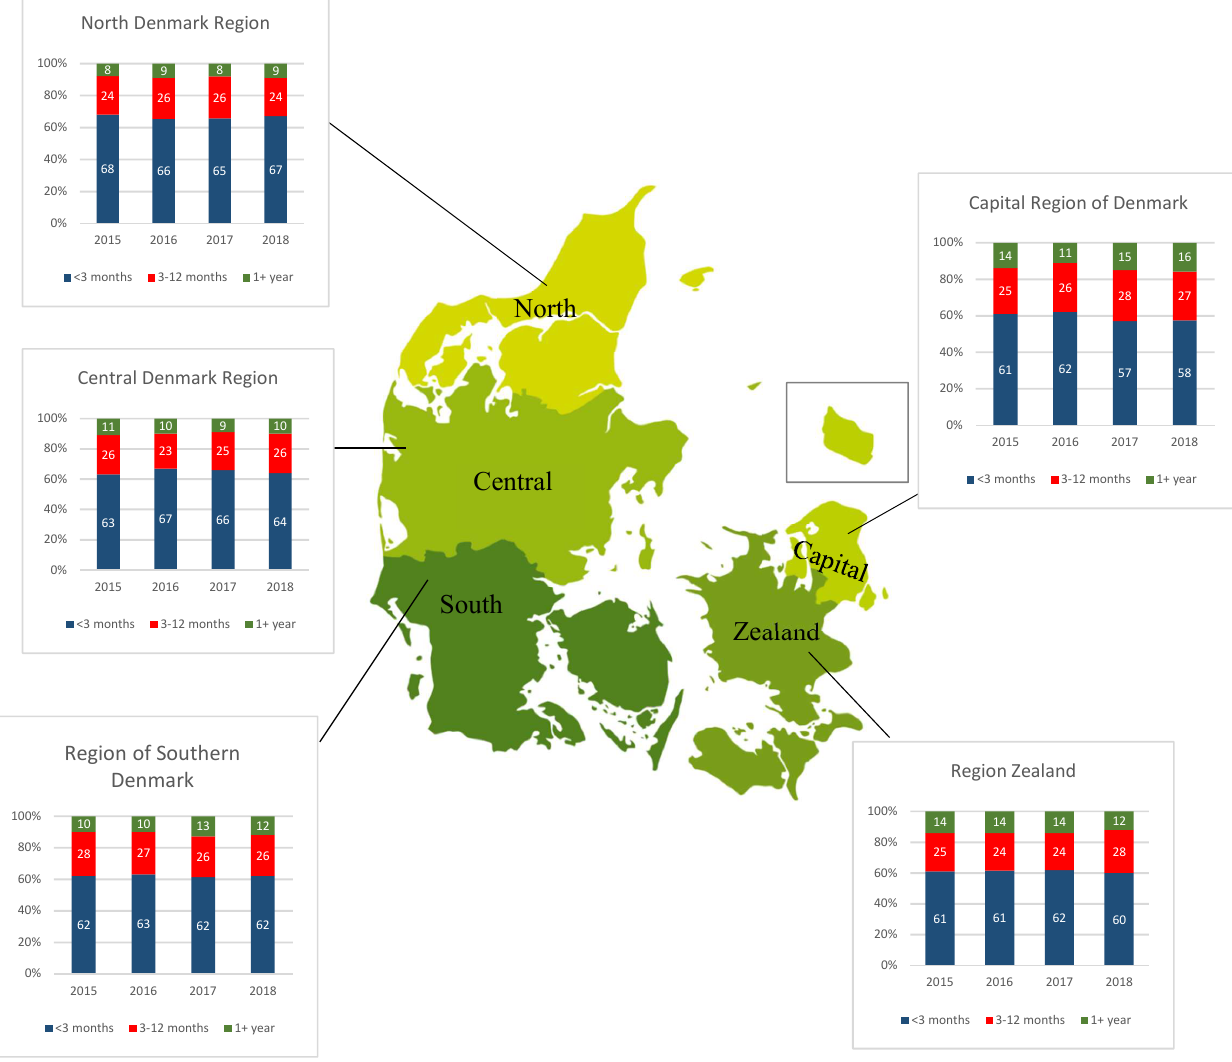
Figure 2. Percentages of short, medium, or long time to end-of-life by region in Denmark. Note: Time to end-of life: Short (<3 months), Medium (3–12 months), Long (1+